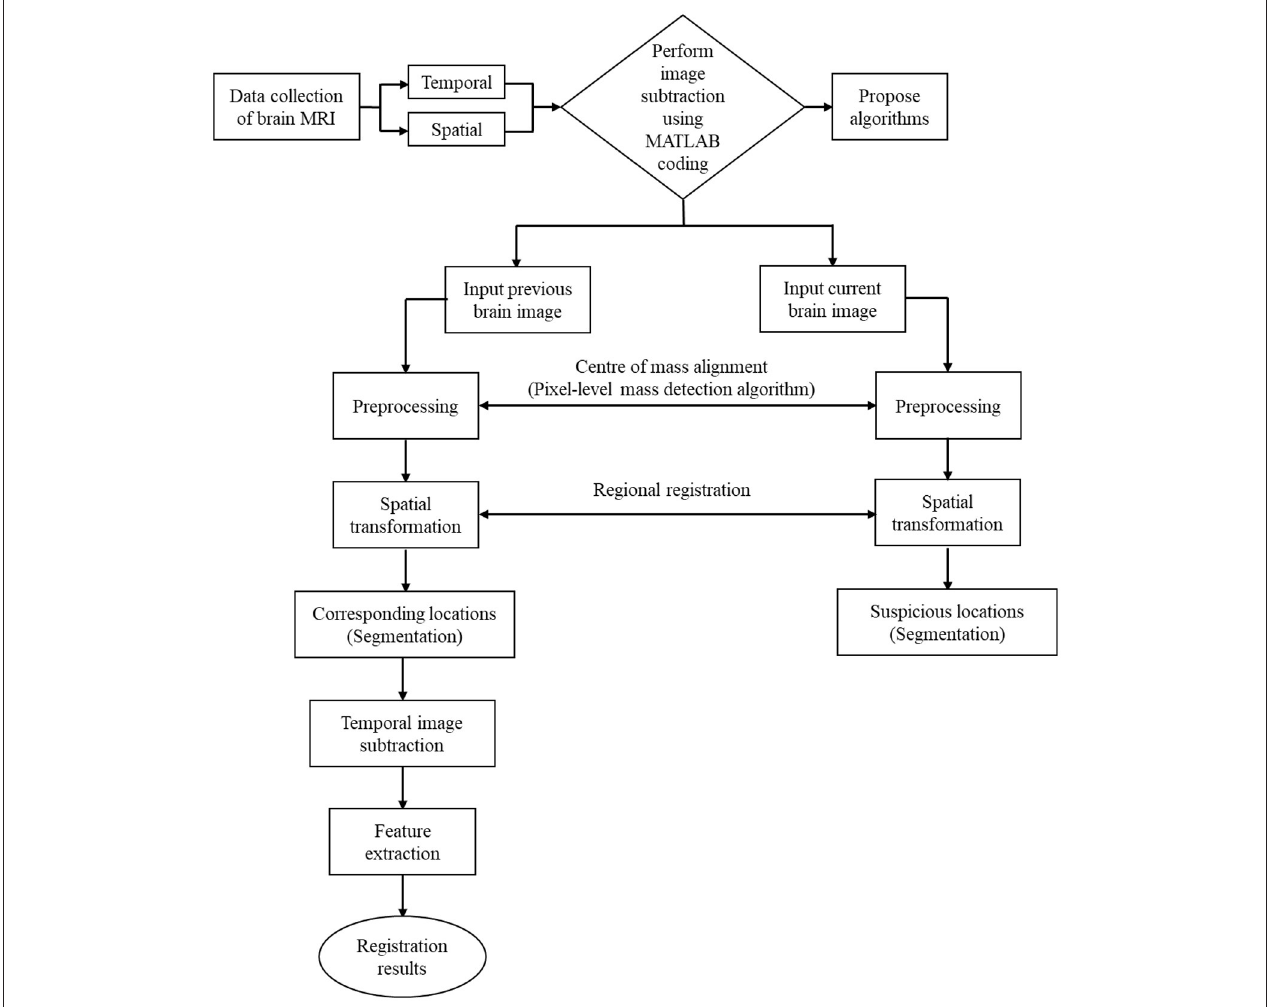
FIGURE 1 | Overall process of image